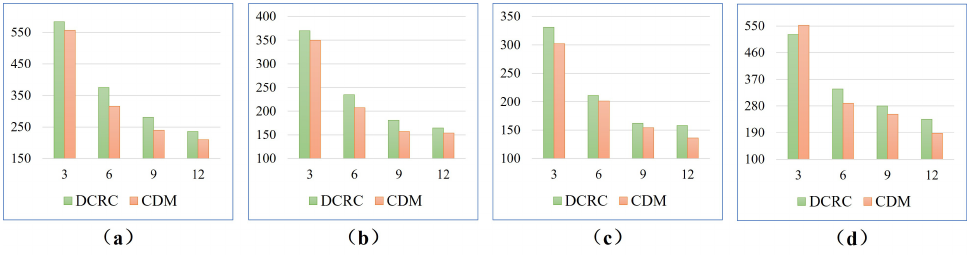
Figure 16. The comparison of coverage times for four different environments. Less coverage times are better. ( a – d ) show comparison results in multi-cell, farm, rual quebec, and cave scenes, respectively.